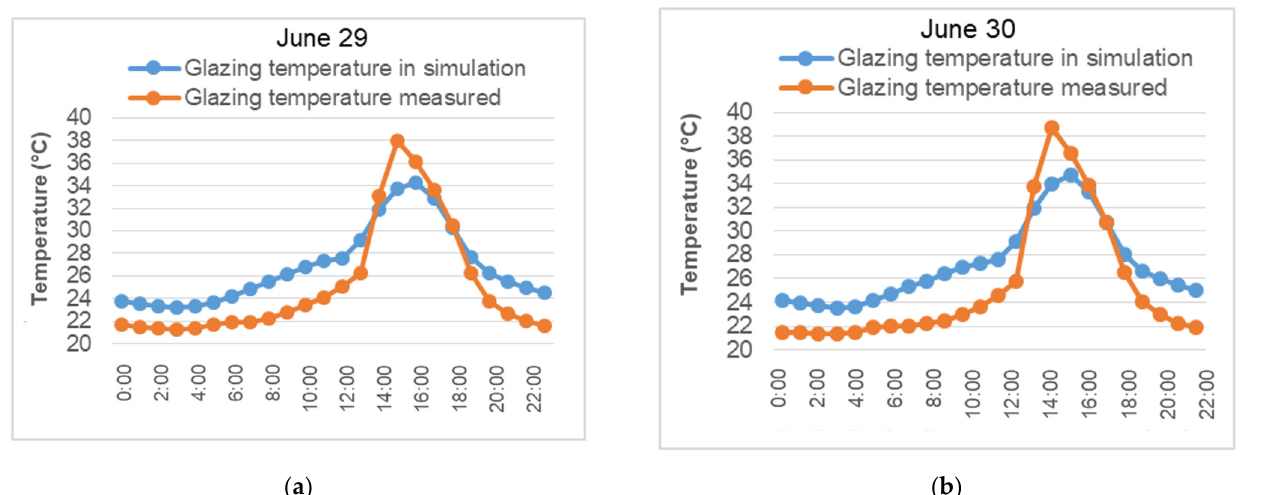
Figure 9. Comparison of all-day surface temperature profiles measured in a centre of the window glazing with simulation results: ( a ) for 29 June, ( b ) for 30 June.